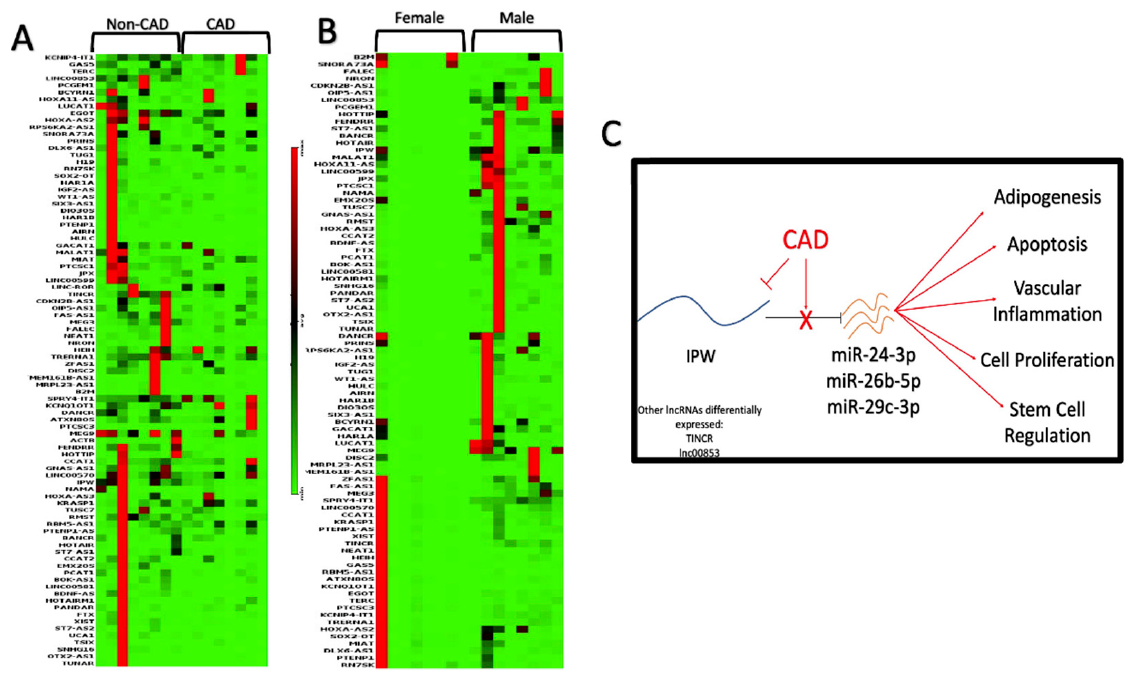
Figure 7. DElncRNAs in EAT: LncRNA array and data analysis was conducted using Qiagen GeneGlobe analysis tool. Red: higher expression; green: low expression. DElncRNAs expression for male patients with or without CAD. The lncRNAs with statistically significant differential expression were TINCR, IPW, and LINC00853 ( A ). Sex differences in DElncRNAs in patients without CAD. The lncRNAs with statistically significant differential expression were RMST, MEG9, and LINC00853 ( B ). lncRNA–miRNA interactions were determined in the DElncRNAs in EAT based on CAD status in males. In CAD male patients, IPW downregulation leads to an increase in the levels of the miRNAs hsa-miR-24-3p, hsa-miR-26b-5p, and hsa-miR-29c-3p, associated with adipogenesis, apoptosis, vascular inflammation, cell proliferation, and stem cell regulation as determined by TAM 2.0 ( C ).